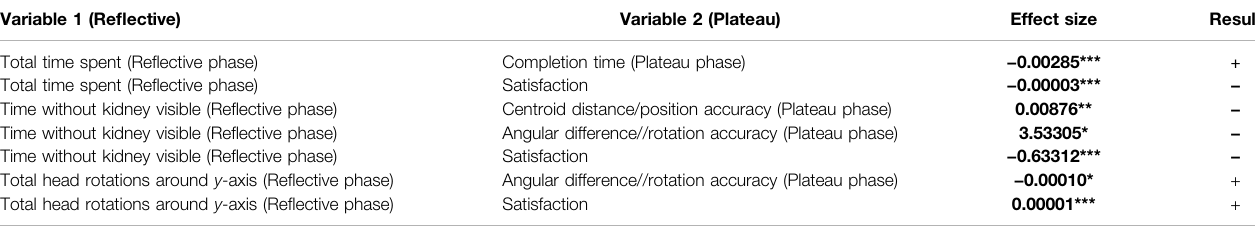
+ desirable, − not desirable, ***signi fi cant at the 1% level, **signi fi cant at the 5% level, *signi fi cant at the 10% level. Note that centroid distance is the measure for position accuracy (distance between centroids of the tissue block and target block) and angular difference is the measure for rotation accuracy (difference in orientation between the tissue block and target block). The effect size can be negative or positive and captures the in fl uence of variable 1 on variable 2 with 1%, 5%, and 10% signi fi cance levels indicated by